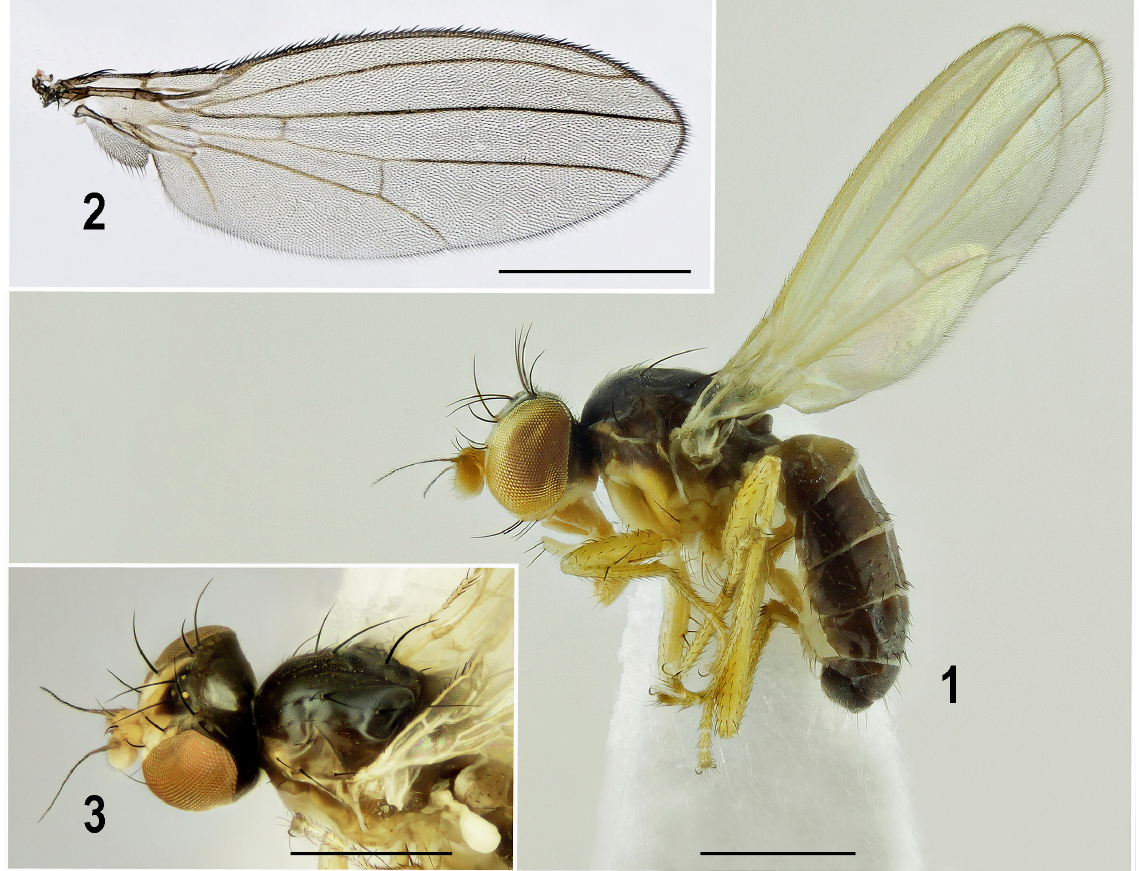
Figs 1–3. Mumetopia interfeles Roháček sp. nov., ♂. 1 . Holotype (SMOC MIT001), lateral view. 2 . Right wing, paratype (SMOC MIT003). 3 . Head and thorax, paratype (SMOC MIT002), laterodorsal view. Scale bars = 0.5 mm. Photos by P.